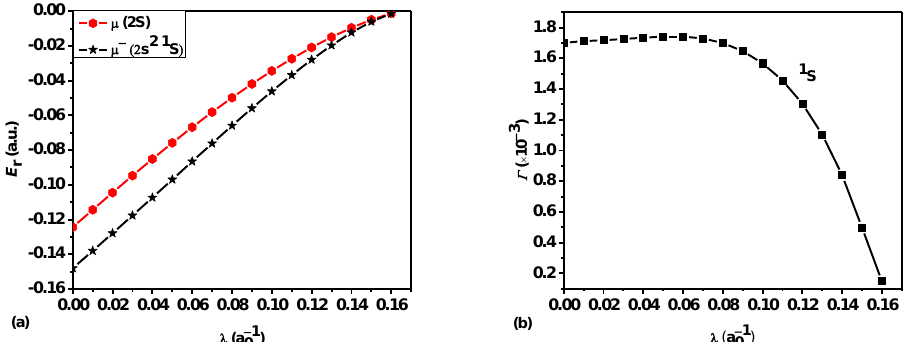
Figure 4. ( a ) Plot of the lowest 1 S e resonance energy 𝐸 𝑟 of Mμ − vs. the screening parameter 𝜆 . ( b ) Plot of the resonance width 𝛤 of Mμ − vs. the screening parameter 𝜆 .